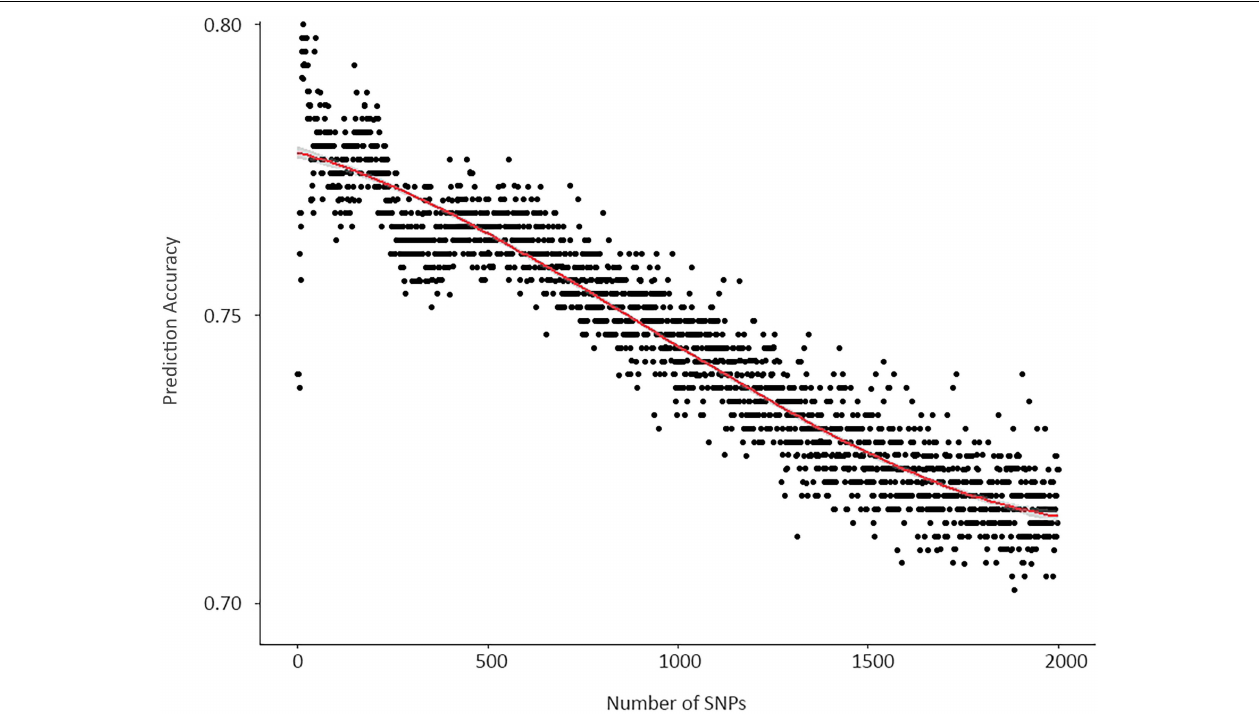
FIGURE 2 | Prediction accuracy of RF models by the number of SNPs included as predictors.